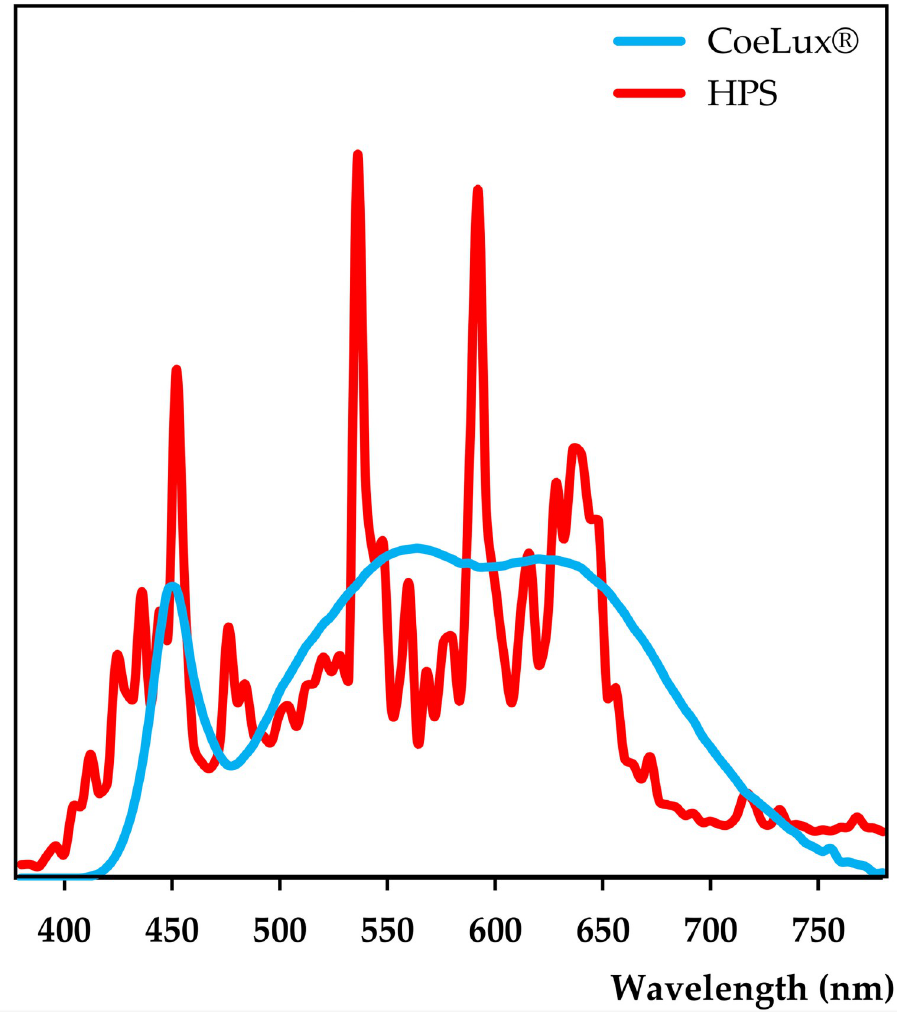
Fig 2. Mean spectra curves of the CoeLux 1 and HPS light types. Under both light types, at least 8 spectra measurements were collected in the range between 380 nm and 780 nm. To allow the comparison, the curves were normalised on the respective luminance value.